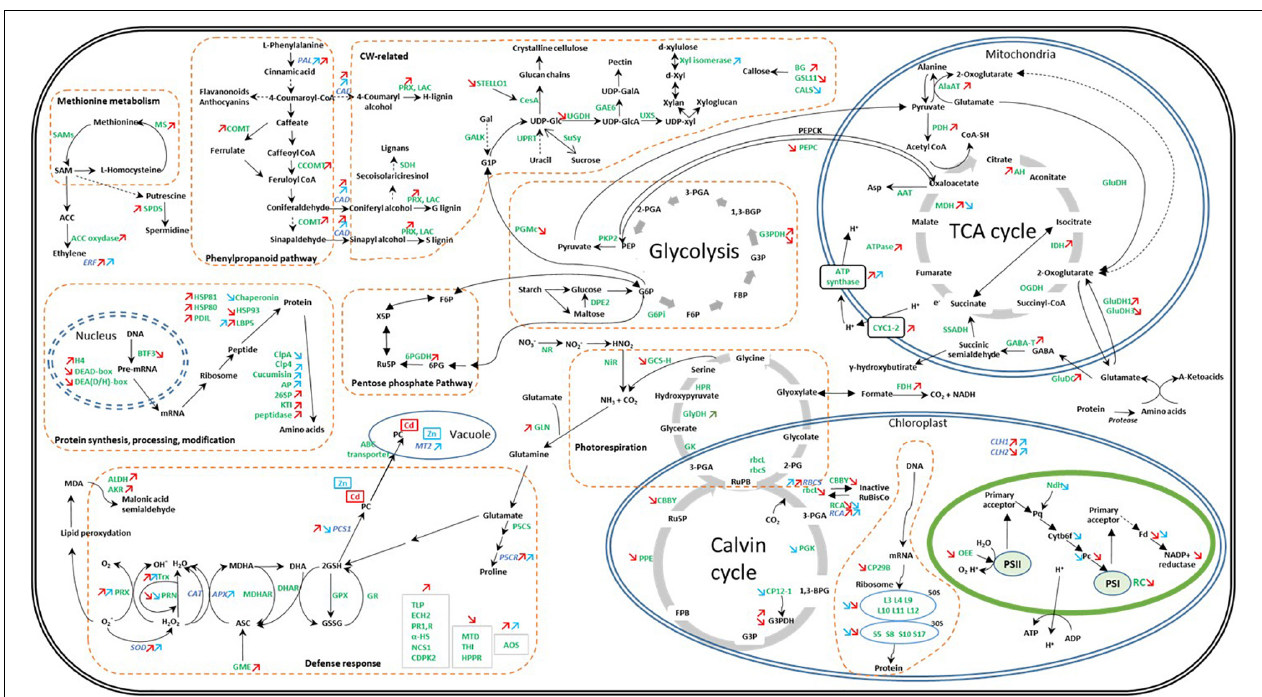
FIGURE 7 | Global overview of the impact of Cd and Zn on the abundance of proteins and transcripts involved in the cell metabolism in hemp leaves. Seedlings were exposed for 1 week either to Cd 20 µ M, Zn 100 µ M, or Si 2 mM. Colored arrows indicate a significant effect of Zn (in blue) or Cd (in red). Adapted from Liu et al.